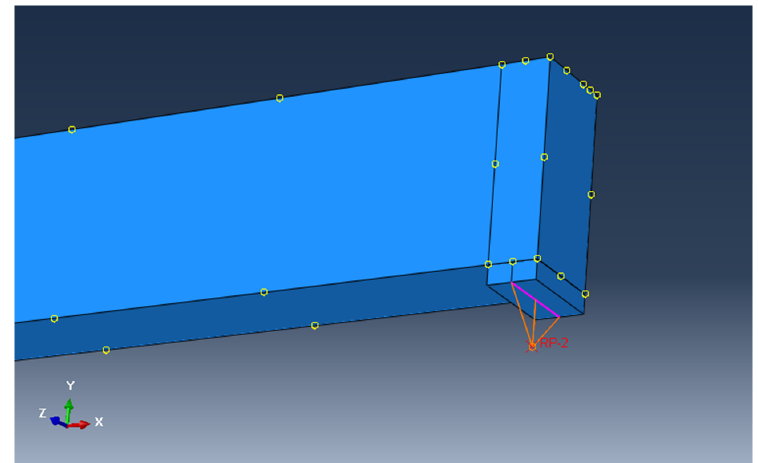
Figure 3. Support interaction with reference points.